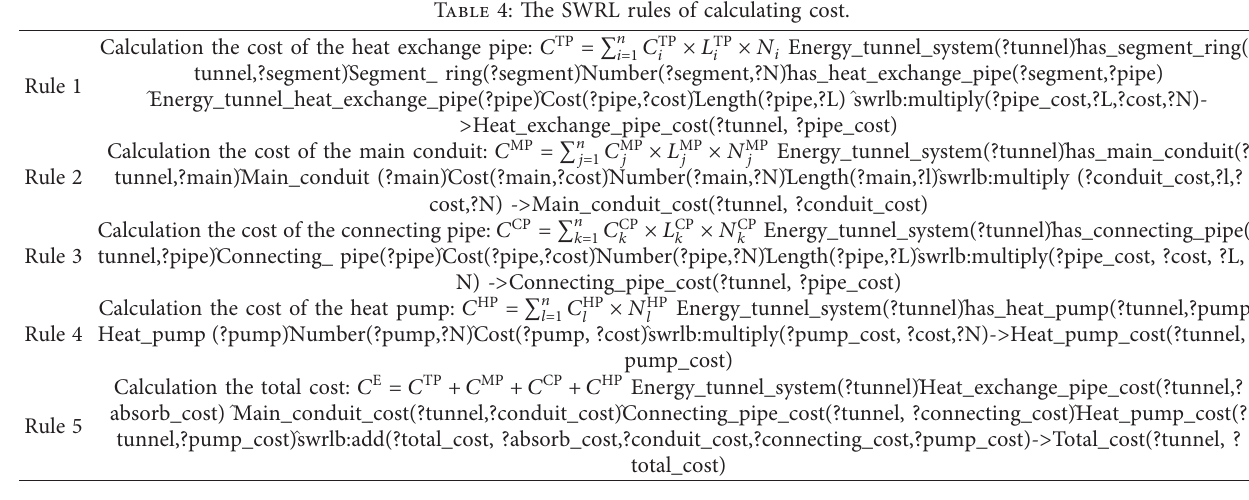
Table 4: The SWRL rules of calculating cost.